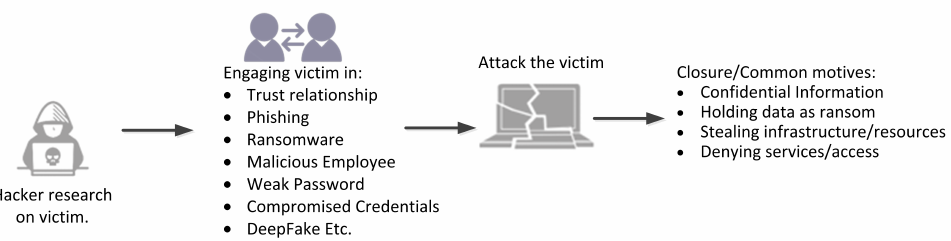
Figure 1. A basic flow of social engineering-based cyberattacks.